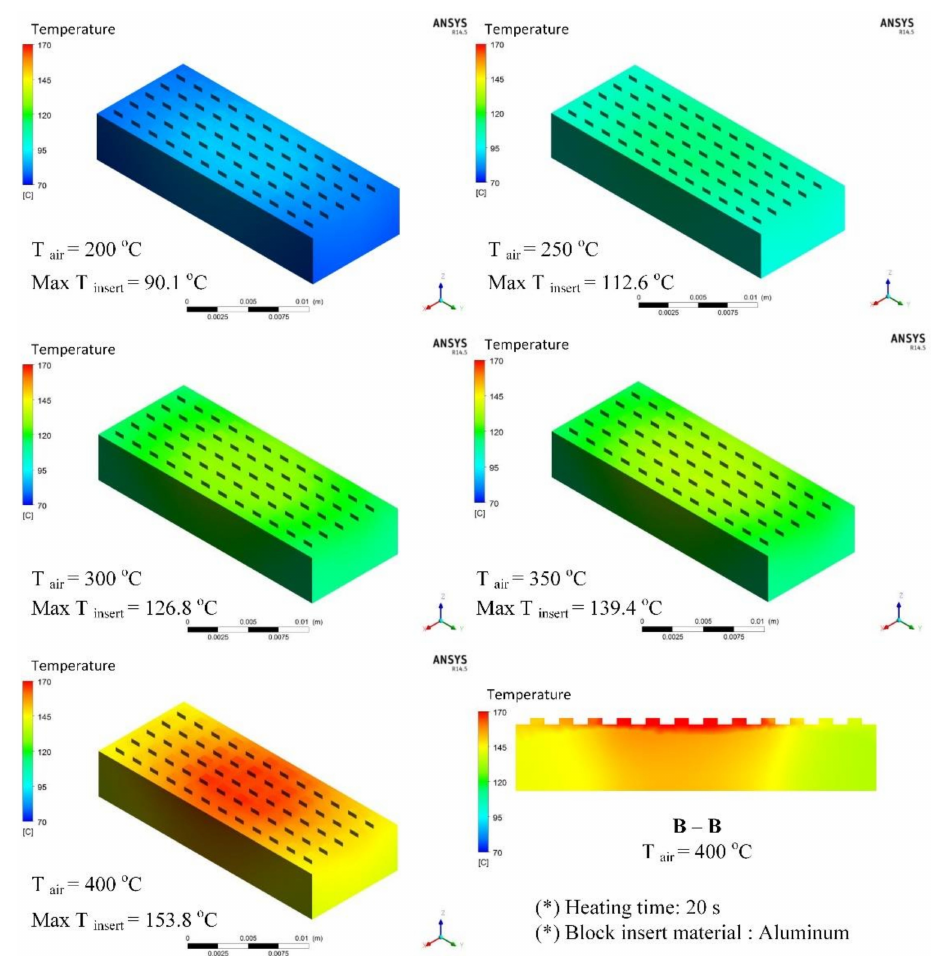
Figure 15. Temperature distribution of block insert with a heating time of 20